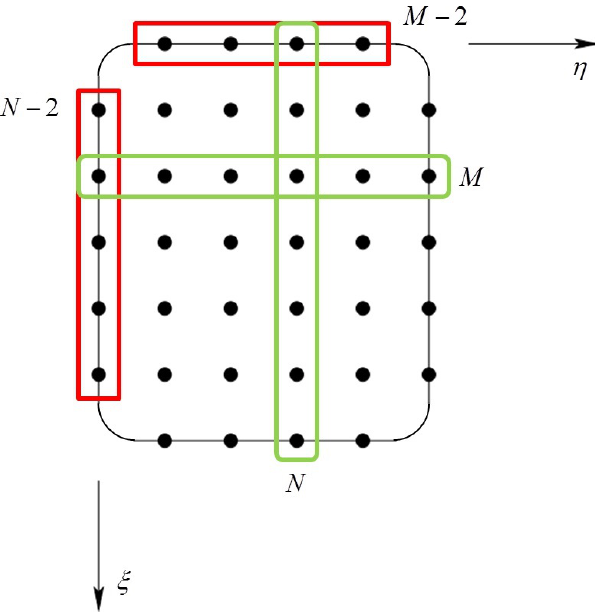
Figure 5: Grid points involved in the derivative approximation, when the corner points are avoided from the implementation. The boxes on the edges are related to the boundary points which have two points less than inner rounded boxes.